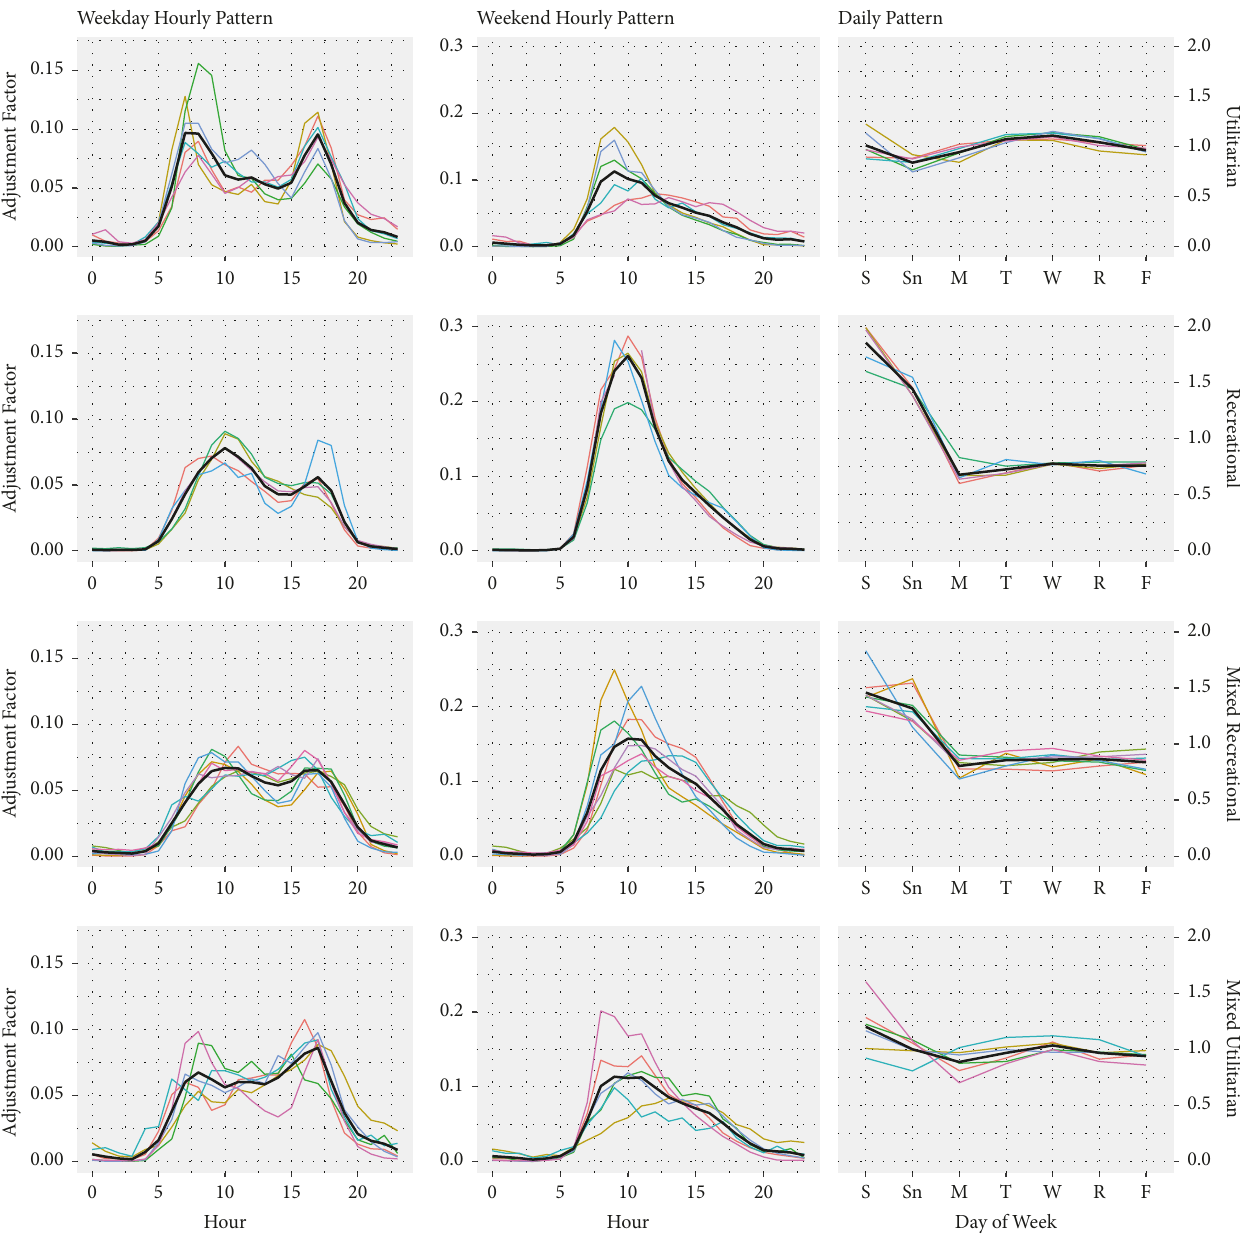
Figure 7: Clusteringresult of long-term bicycle countersclassified intofour groups (Utilitarian, Recreational, Mixed Recreational, and Mixed